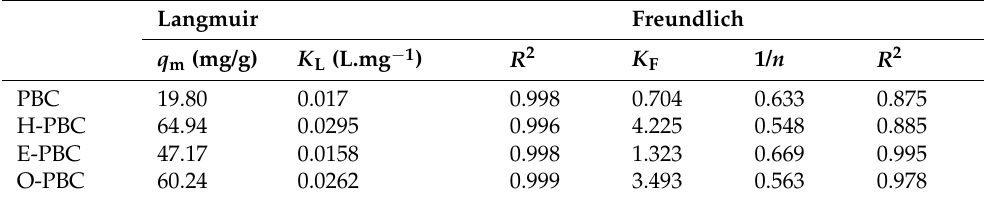
Table 6. Parameters fitted to Langmuir and Freundlich models of Ni(II) adsorption by PBC, H-PBC, E-PBC, and O-PBC.